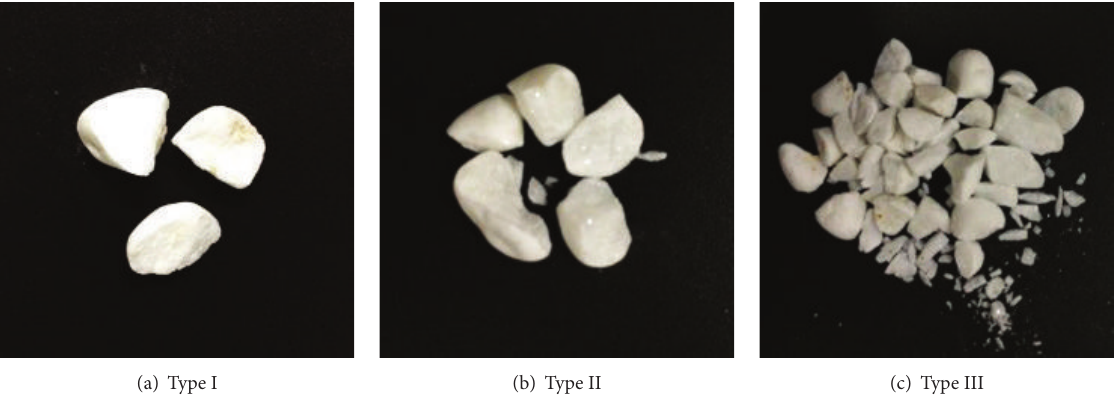
Figure 4: Mother particle and its